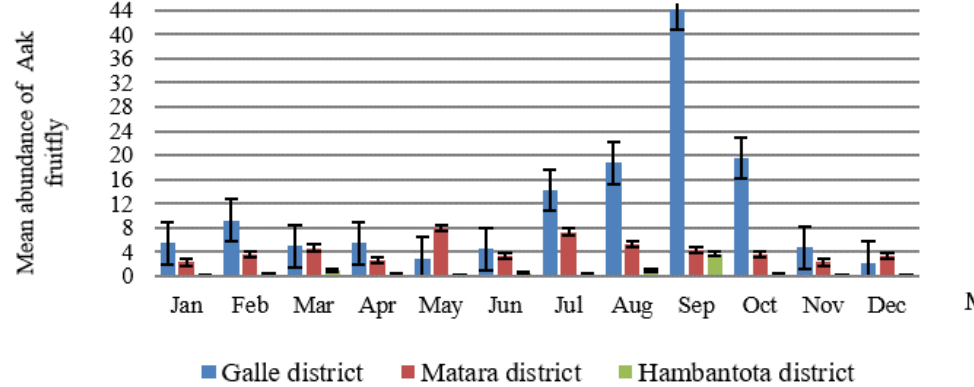
Figure 2 : Temporal variation of mean abundance of Aak fruit fly ( Dacus persicus ) in districts of Southern Province.